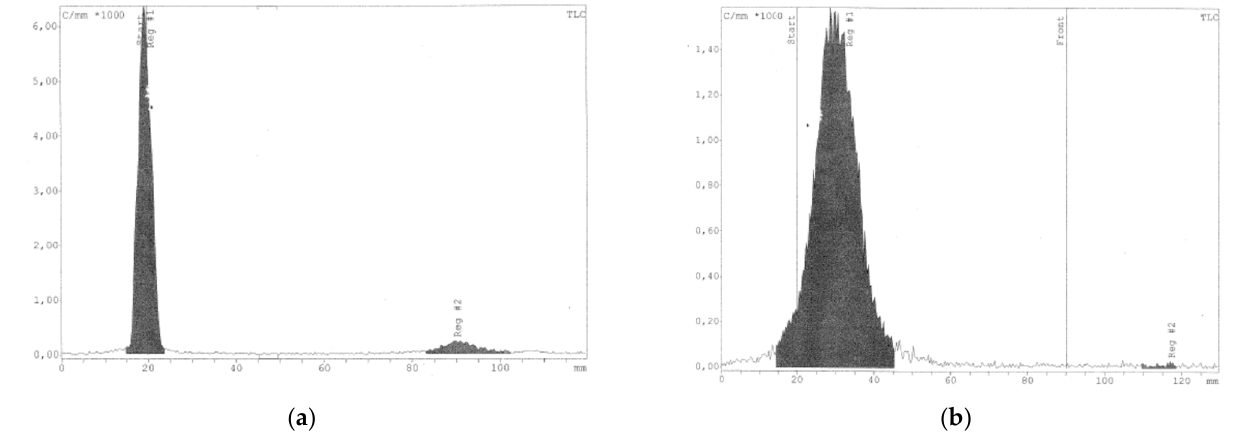
Figure 1. Quality controls (QC) performed to verify the labelling yield of 99m Tc bound/unbound to MAA ( b ) and 68 Ga bound/unbound to MAA ( a ). Labelled MAA remains at the point of application, while free isotope migrates with the solvent front (TLC-SG; CH 3 OH:H 2 O 85:15 and 0.1 M tribasic- citrate solution for Tc and Ga, respectively). Table 1. Activity distribution in Pulmocis preparation, shown as a percentage (Mean (SD)). Bound Fraction %